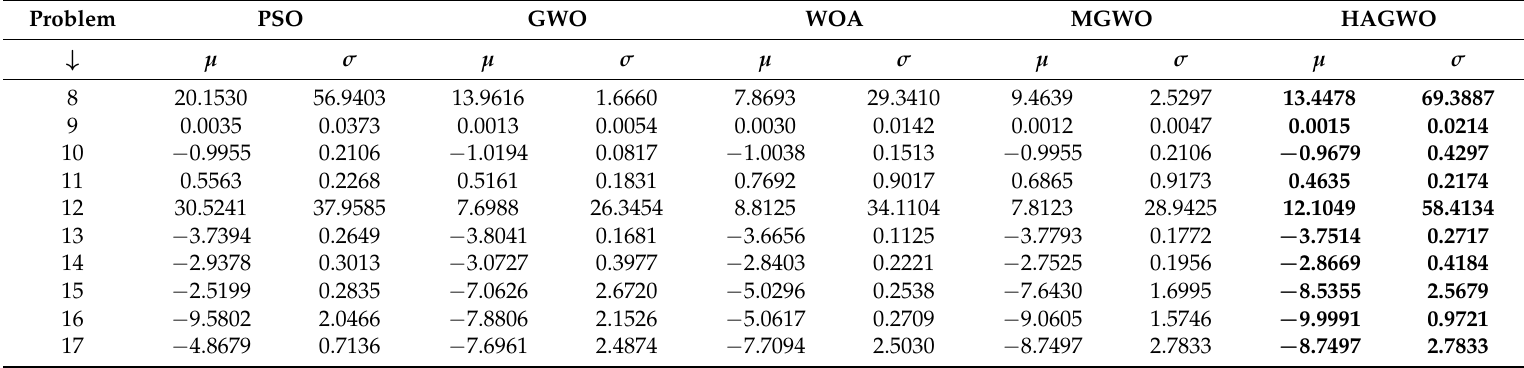
Table 9. Statistical results of fixed-dimension multimodal benchmark